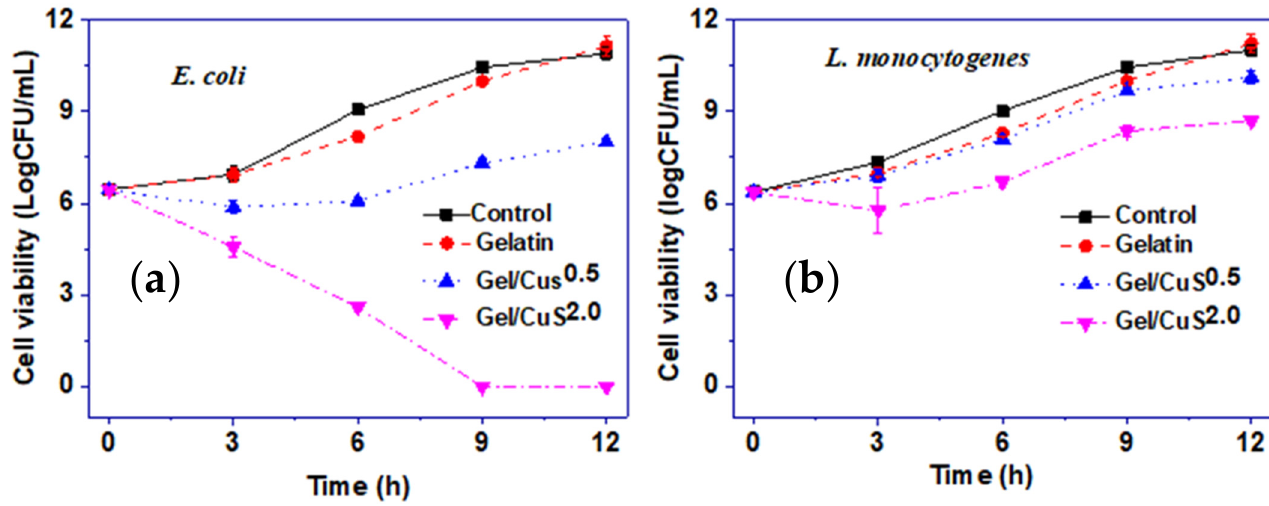
Figure 6. Antimicrobial activity of Gel/CuSNP films against ( a ) E. coli and ( b ) L. monocytogenes .